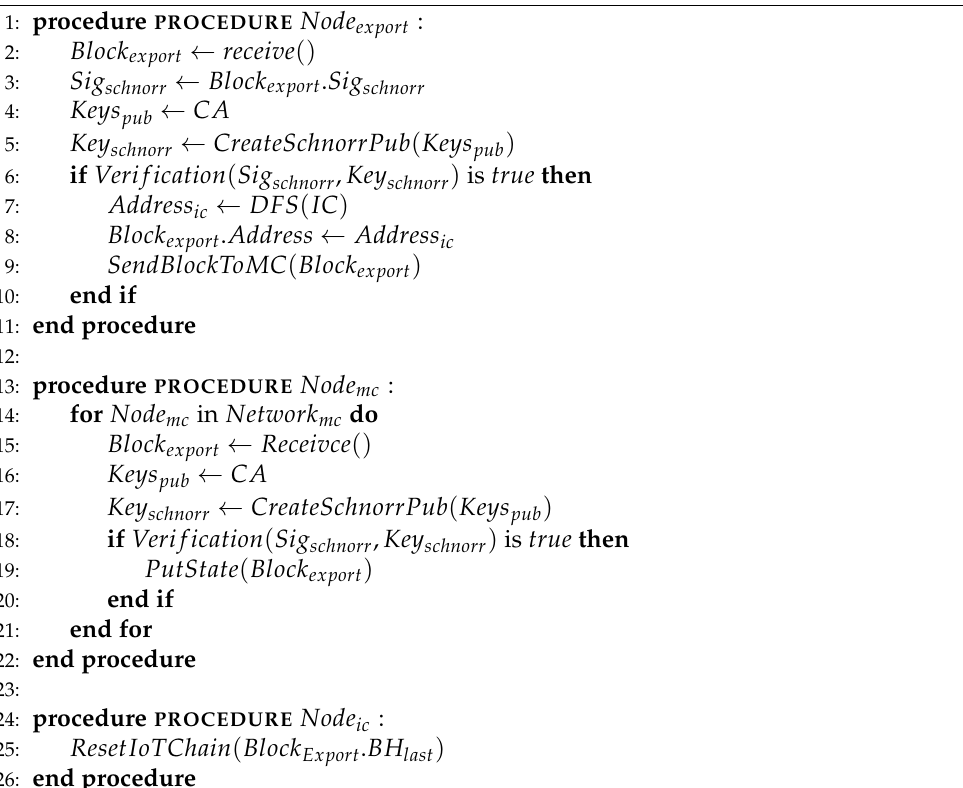
Algorithm 4 Block export